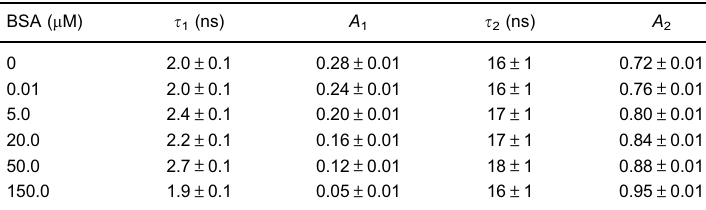
Data are reported as means ± SD. BSA: bovine serum